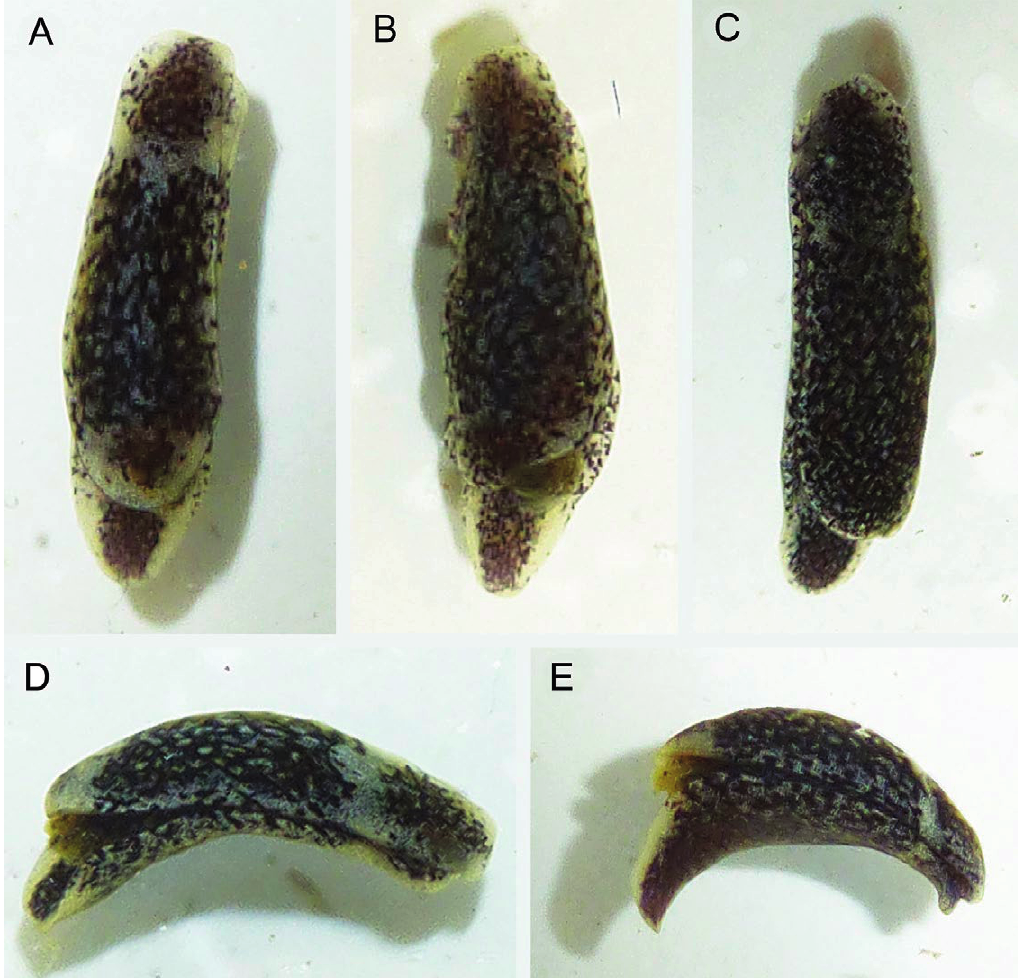
Fig. 3. – Living animals of Runcina lusitanica n. sp. (south coast of Portugal). A (MNCN 15.05/88092), D (MNCN 15.05/200065), E (MNCN 15.05/88094); specimens showing the absence of dark blotches on the posterior part of the head and notum. B (MNCN 15.05/88091), C (MNCN 15.05/88093); specimens with dark blotches covering the whole